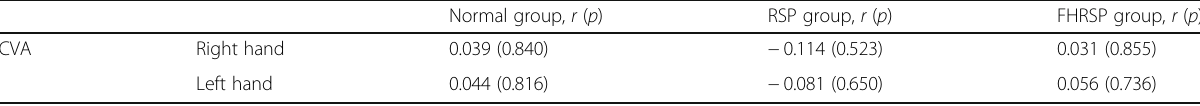
Table 4 Correlation between the CVA (degrees) and hand grip strength (kg) Normal group, r ( p ) RSP group, r ( p ) FHRSP group, r ( p ) CVA Right hand 0.039